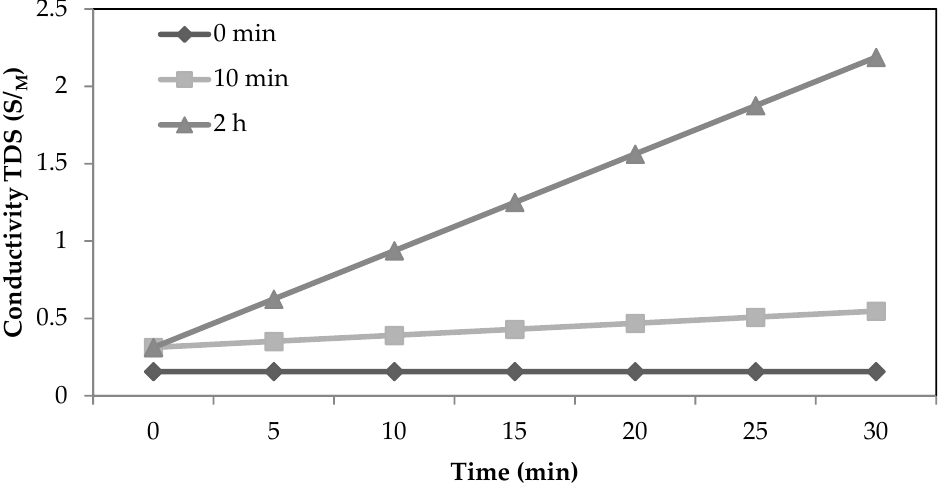
Figure 7. Rate of conductivity increase in the CIP tank after different RCWW exposure times using the PP membrane.